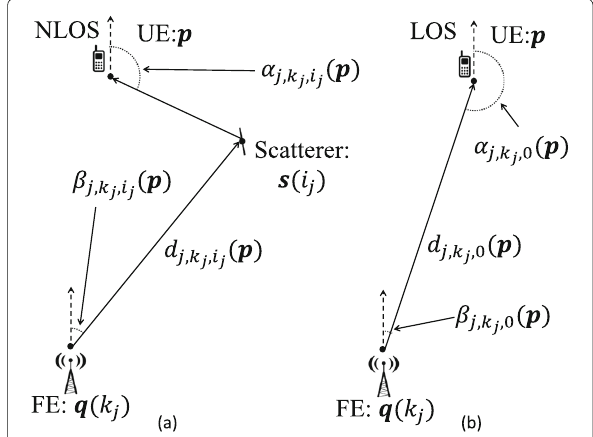
Fig. 2 mmWave localization model for a NLOS and b LOS